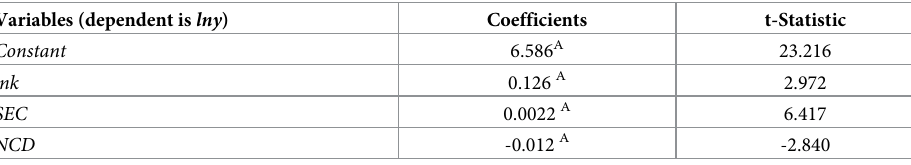
A, B, C indicate significance at 1, 5 and 10 percent